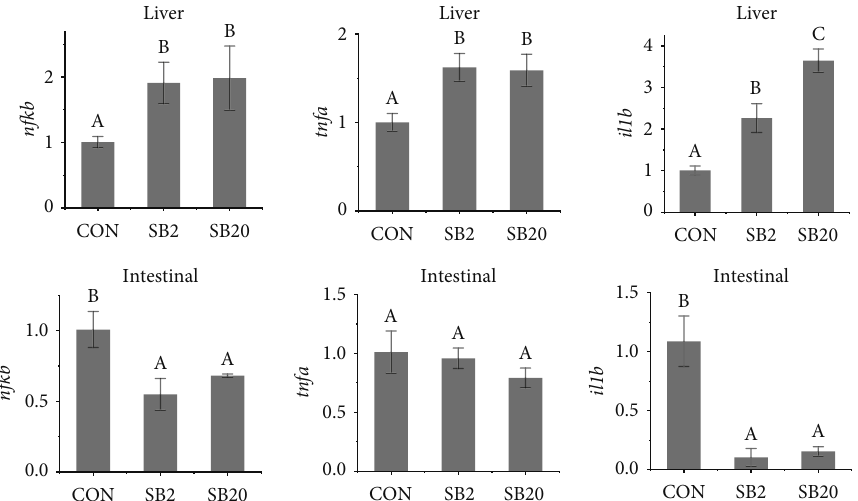
Figure 4: E ff ects of two dosages of sodium butyrate on the relative expression of liver and intestine in fl ammation-related genes in largemouth bass, Micropterus salmoides . nfkb : encode nuclear factor- κβ ; tnfa : encode tumour necrosis factor- α ; il1b : encode interleukin- 1 β . Di ff erent letters above the bars represent signi fi cant di ff erences ( P < 0 : 05 , n = 3 ).